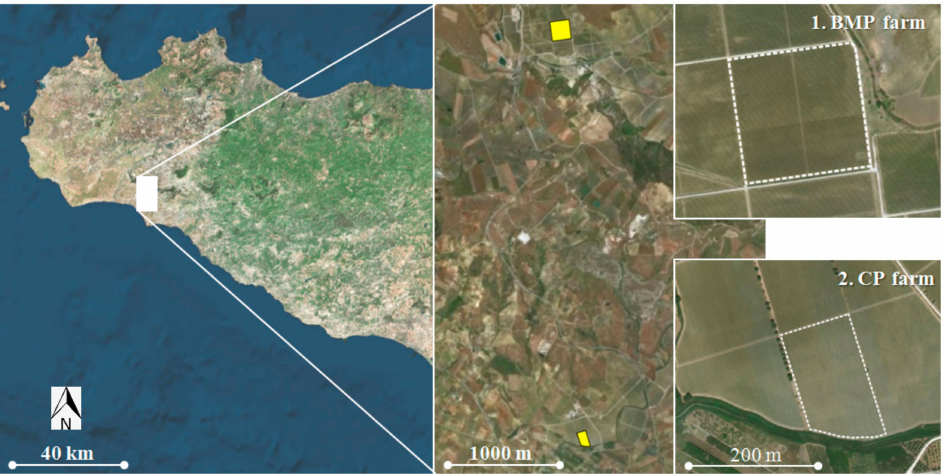
Figure 1. Geographic location of the study area in the Sicily region. The two di ff erent investigated vineyards (Best Management Practices, BMP, and Conventional Practice farm, CP, farms) are